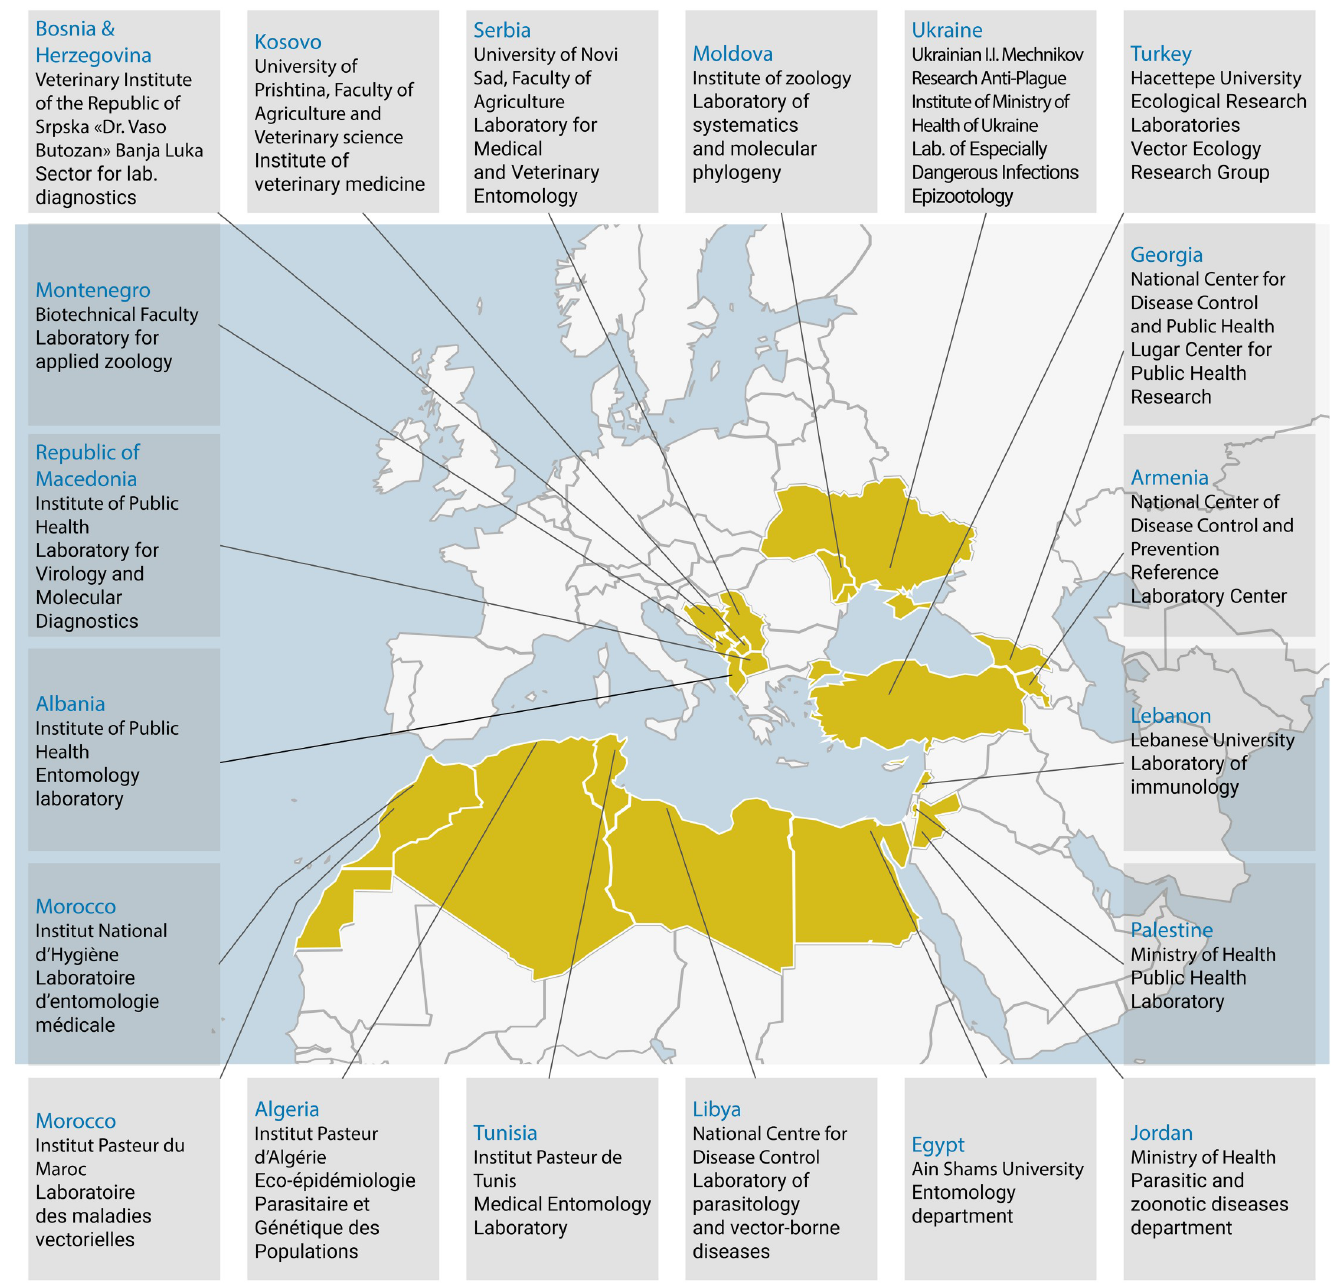
Fig 1. Map of the member countries of MediLabSecure and locations of the laboratories constituting the medical entomology network. The figure was originally published by Jourdain and colleagues [6].Administrative boundaries: IRD, Cartographic service. IRD, French National Research Institute for Sustainable Development.